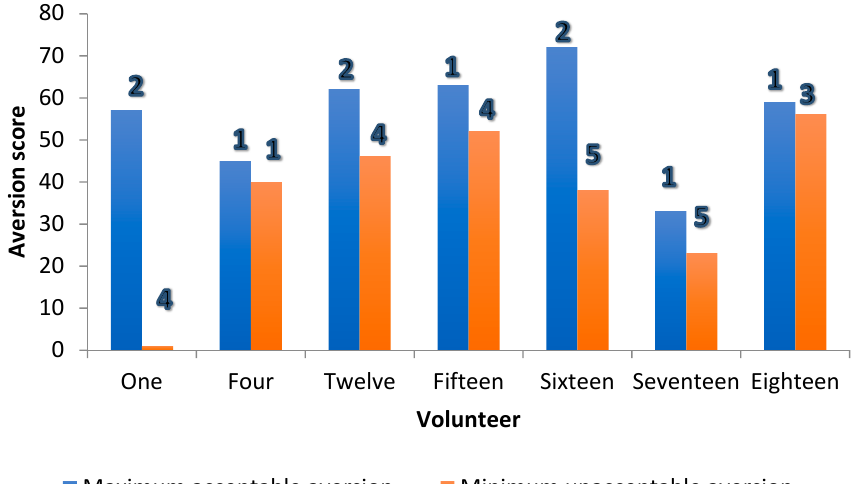
Figure 5. Threshold aversion (bars) and grittiness scores (numbers 1–5) for formulations in seven volunteers where the expected difference in mean individual taste scores between “acceptable-as-a-medicine” and “unacceptable-as-a-medicine” aversion score was not observed.